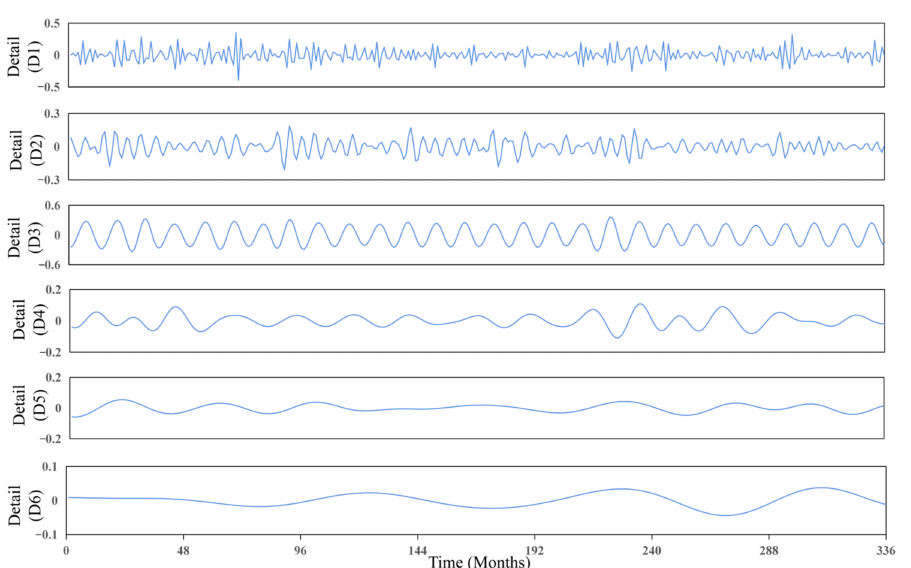
Figure 10. Decomposition sequence of rainfall.